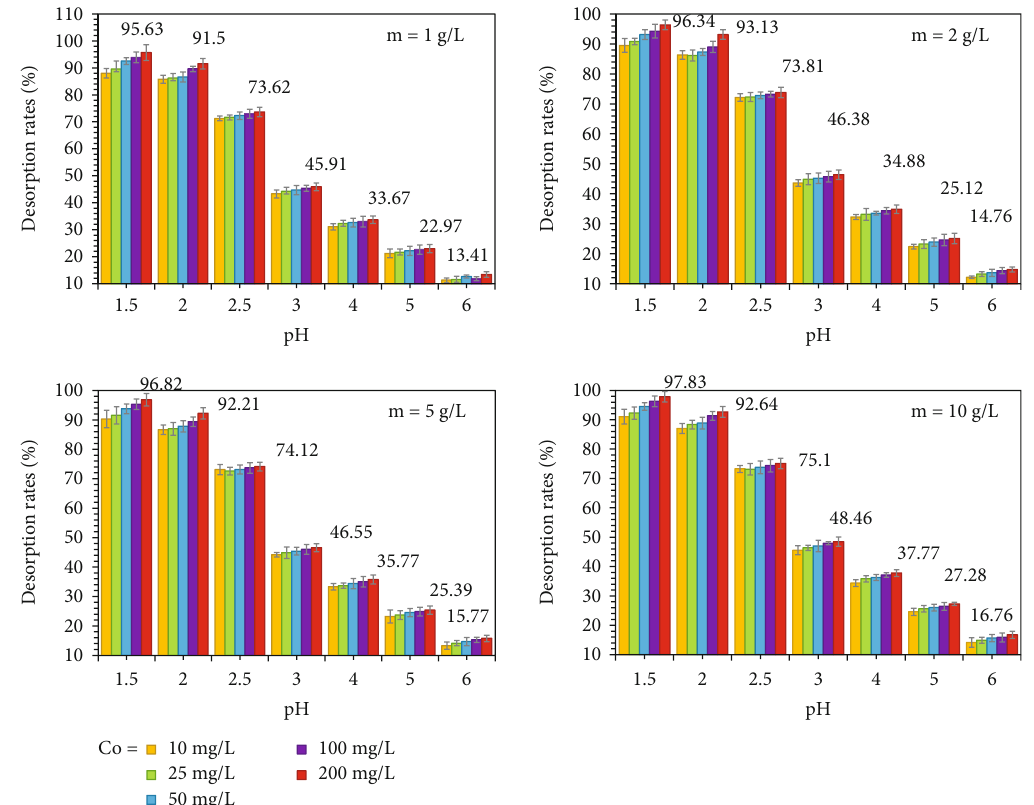
Figure 10: Desorption rates of Pb (II) versus pH graphs for di ff erent adsorbent dosages. ± SD shown by error